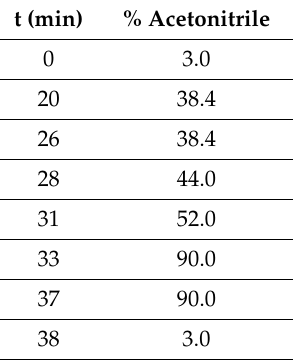
Table 1. High-performance liquid chromatography-reverse-phase solvent gradients used at various time points for protein-peptide separation and